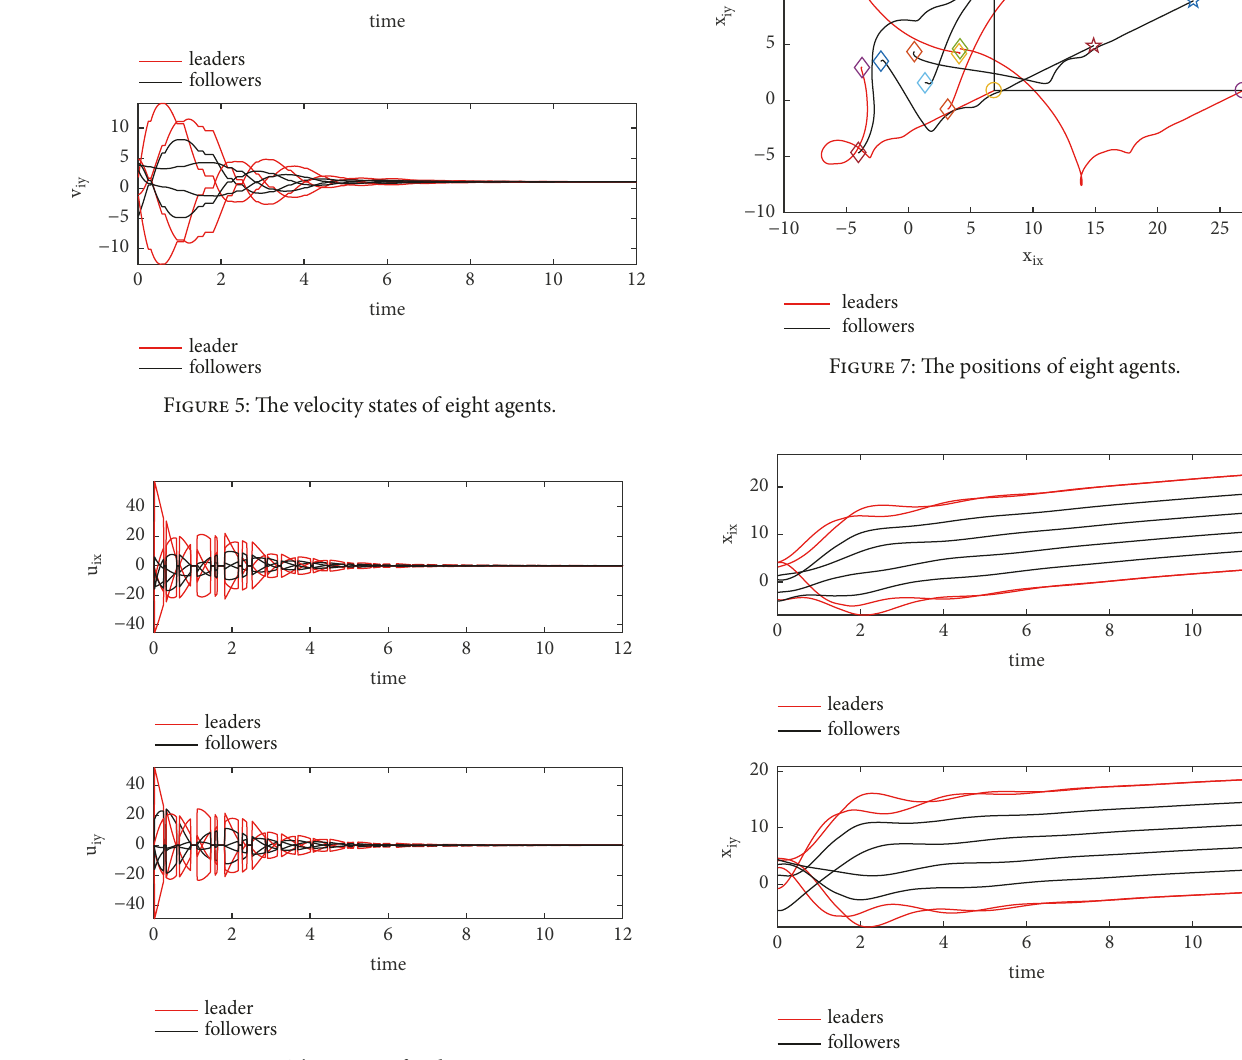
Figure 8: The moving trajectories of eight